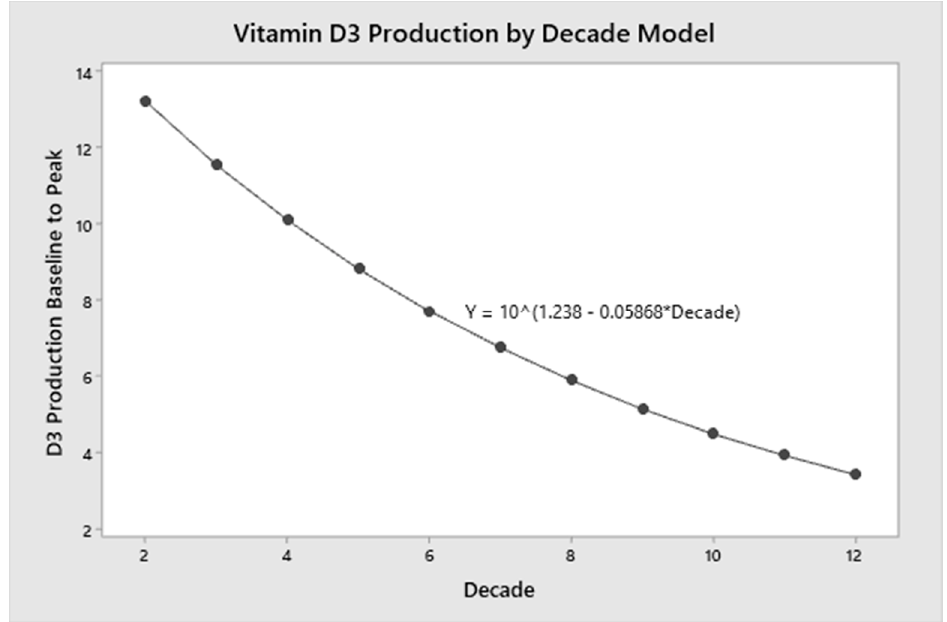
Figure 4. Vitamin D 3 Production Age Continuum Modeling. The simple linear regression model with decade as the independent variable and log D 3 production was used to demonstrate the 13% decrease in D 3 production per decade of life. D 3 production at age 70 years is approximately half that produced at age 20. The graph demonstrates that D 3 production is possible even in the later decades of life.